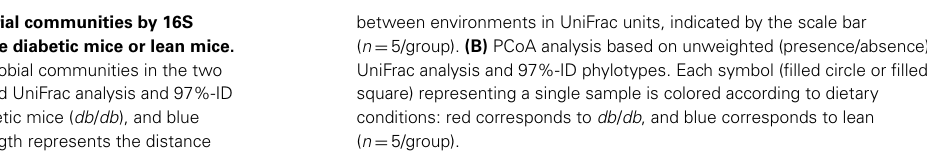
between environments in UniFrac units, indicated by the scale bar ( n = 5/group). (B) PCoA analysis based on unweighted (presence/absence) UniFrac analysis and 97%-ID phylotypes. Each symbol (filled circle or filled square) representing a single sample is colored according to dietary conditions: red corresponds to db / db , and blue corresponds to lean ( n =